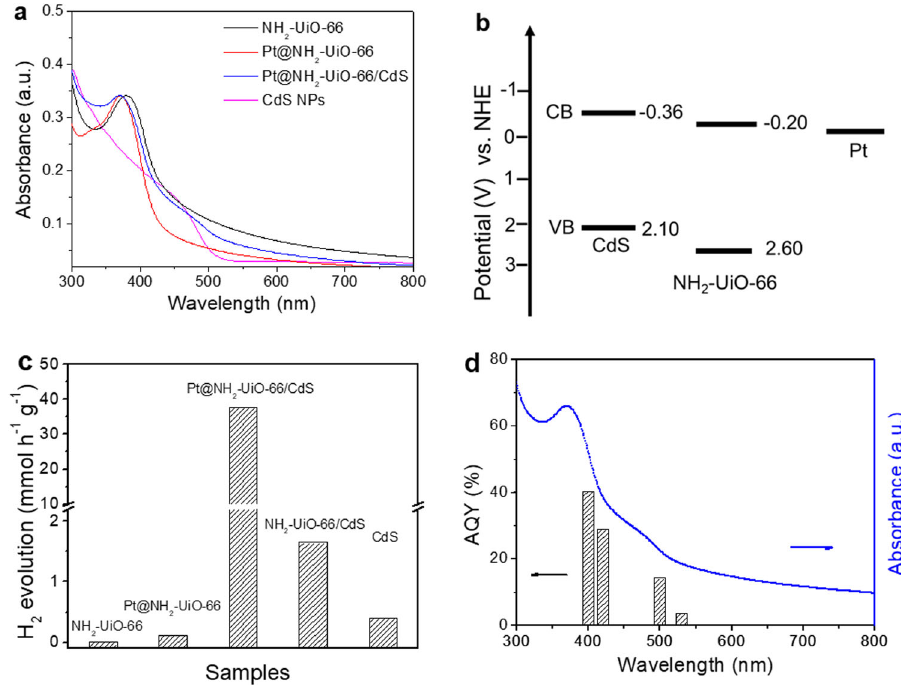
Fig. 2 Optical properties, band diagram, and photocatalytic hydrogen evolution. a Ultraviolet – visible absorption spectra of NH 2 -UiO-66, Pt@NH 2 -UiO- 66, Pt@NH 2 -UiO-66/CdS and CdS nanoparticles (NPs) in dimethyl formamide. b Energy levels for Pt, NH 2 -UiO-66, and CdS NPs. The black solid lines represent conduction bands (CBs) and valence bands (VBs) for CdS, NH 2 -UiO-66, and the work function for Pt NPs, respectively. c Comparison of the hydrogen evolution rate for NH 2 -UiO-66, Pt@NH 2 -UiO-66, Pt@NH 2 -UiO-66/CdS, NH 2 -UiO-66/CdS and CdS NPs under visible-light (>420 nm), using a lactic acid acetonitrile solution as a sacri fi cial agent. d Apparent quantum yields (AQY) of Pt@NH 2 -UiO-66/CdS at several wavelengths under identical conditions. The blue line shows the absorption